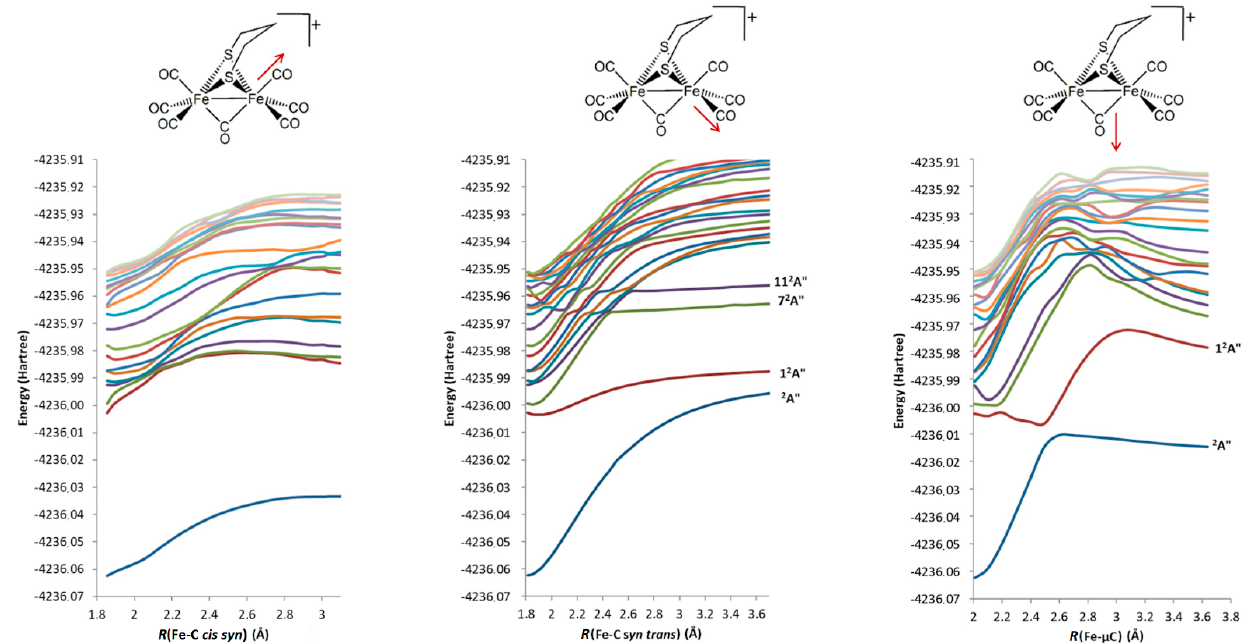
Figure 10. Potential energy surfaces of the ground state and the first 20 singlet excited states of 2 a + –CO along the apical and equatorial Fe–CO stretching coordinates (in Å). In syn trans and µ Fe–CO plots are also evidenced the excitations whose dynamics lead to the CO photolysis after a series of internal conversions.